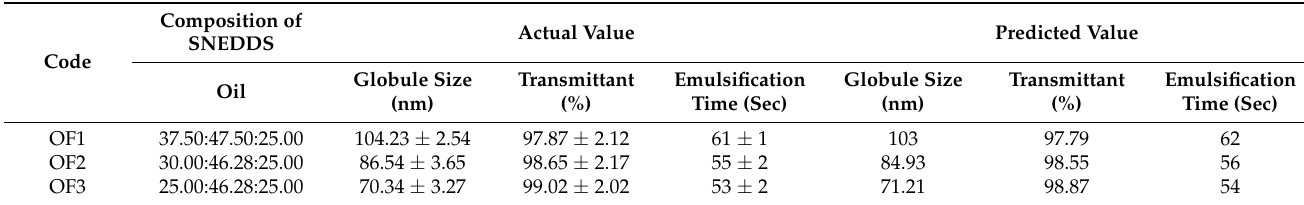
Table 4. Point prediction optimization of SNEDDS from software.